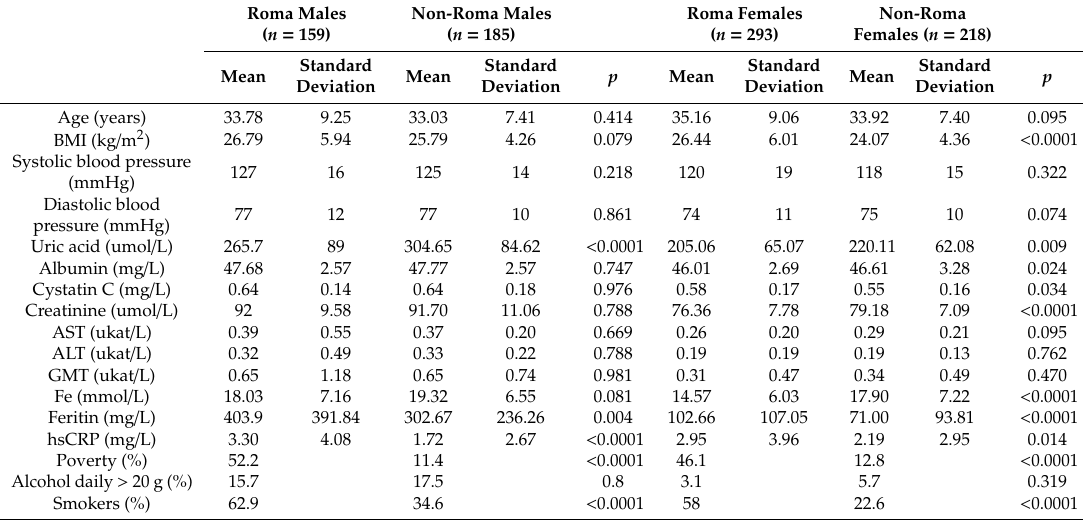
Table 1. Summary of the study parameters by sex and